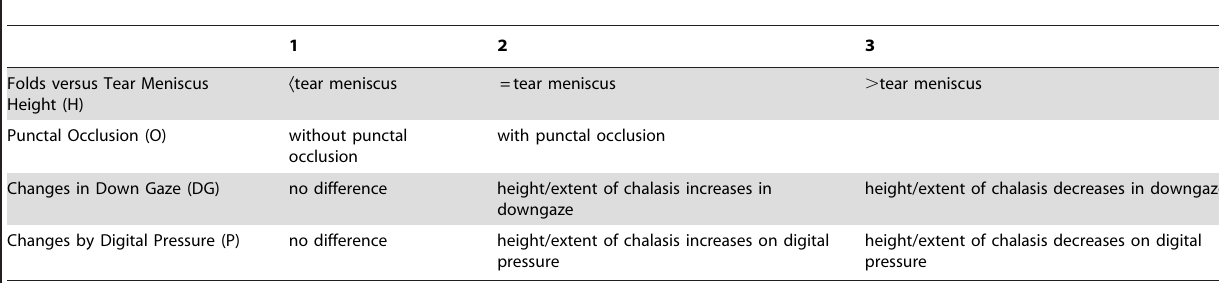
Table 1. Additional grading criteria of